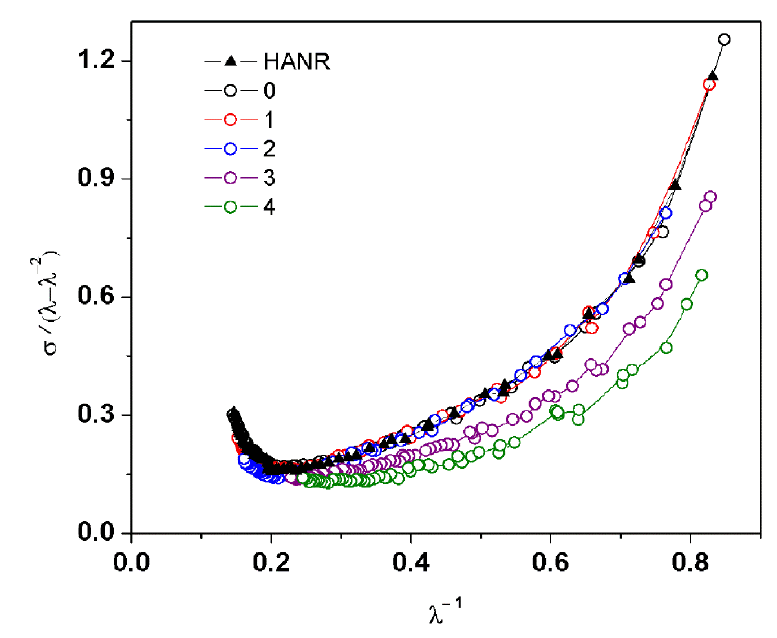
Figure 6. Mooney–Rivlin plots for HANR and DPNRs.